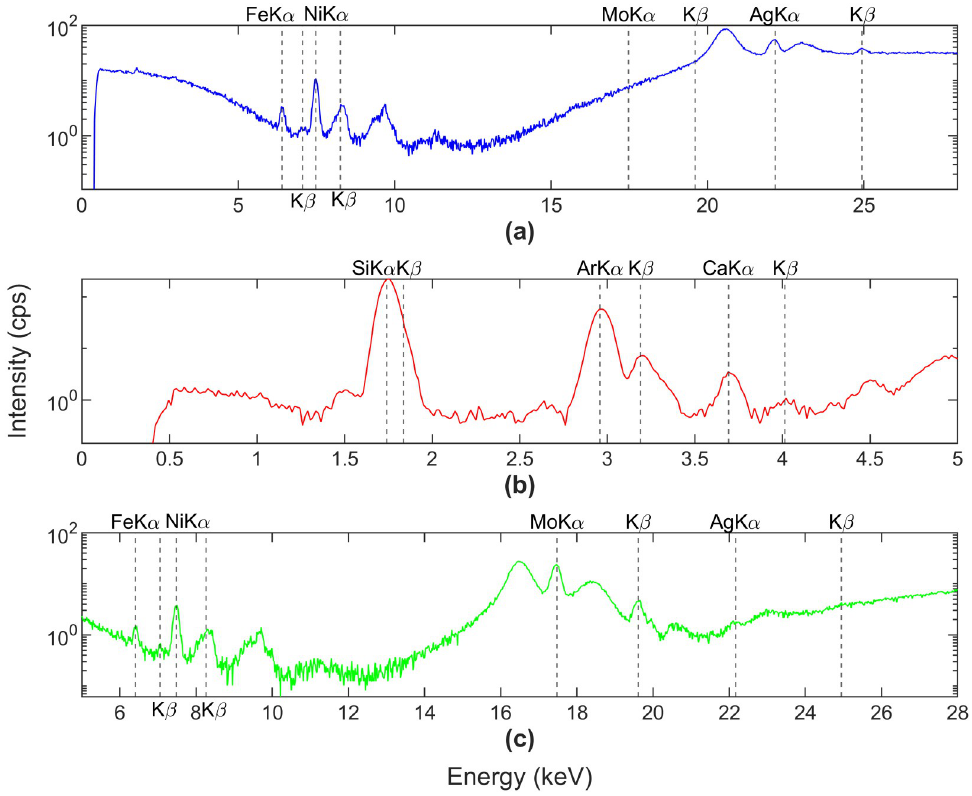
Fig 1. Fluorescent x-ray spectrum of a blank SiO 2 sample. (a) spectrum in ‘Main’ mode without any filters. (b) and (c) are spectra in ‘Low’ mode and ‘High’ mode using Cu and Mo filters, respectively.